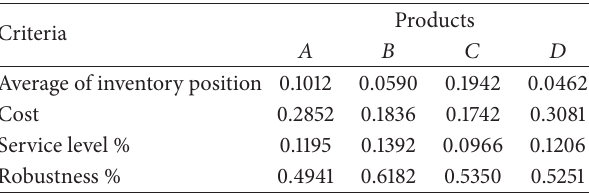
Table 11: Weights of criteria for different products.